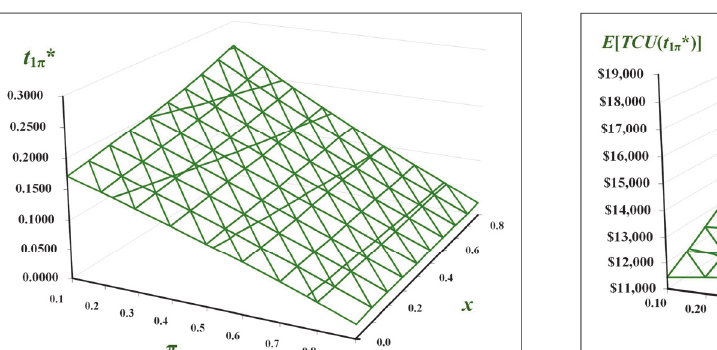
Fig. 14. Effect of variations in π on diverse cost contributors of E [ TCU ( t 1 π * )]